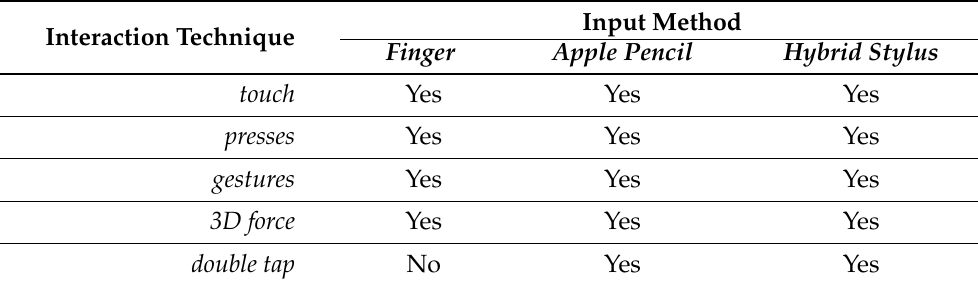
Table 1. The Hybrid Stylus keeps all features of an Apple Pencil but one—the pressure sensitivity, which maintains a constant force in our